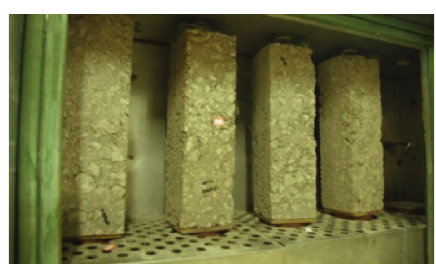
Figure 7: Working of the tester environment box of the beam